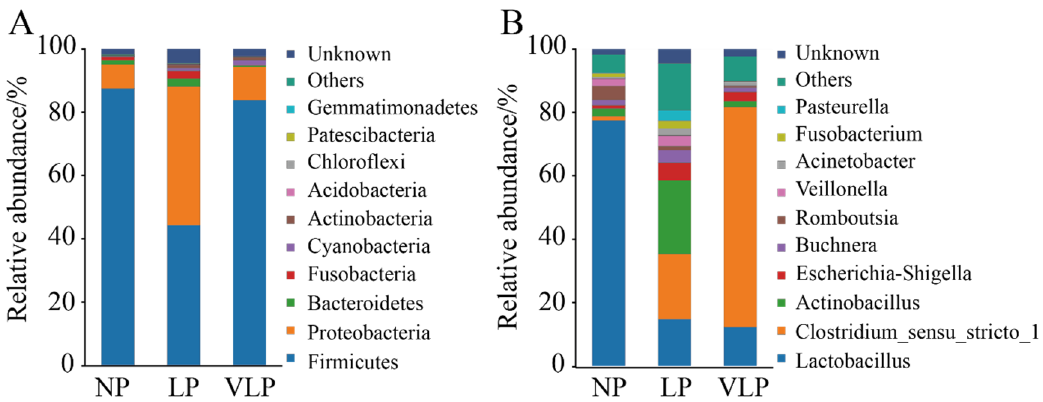
Figure 2. Taxonomic profiles of the gut bacteria in NP, LP, and VLP piglets from 16S rRNA gene sequencing. The relative abundance of the top 10 phylum ( A ) and the top 10 genus ( B ) of gut bacteria present in NP, LP and VLP piglets. NP = normal protein; LP = low-protein; VLP = very low-protein.